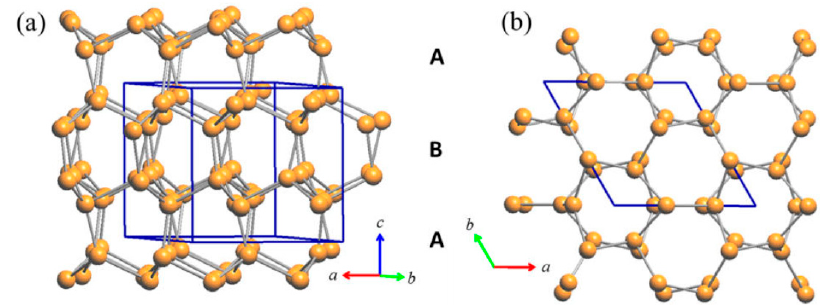
Figure 3. ( a ) Perspective view of the rigid Cu sublattice of the lonsdaleite type formed in the RT- Cu 3 As phase by the contribution of the Cu2 and Cu3 atoms only; ( b ) top view (along the c -axis) of the same lonsdaleite sublattice.